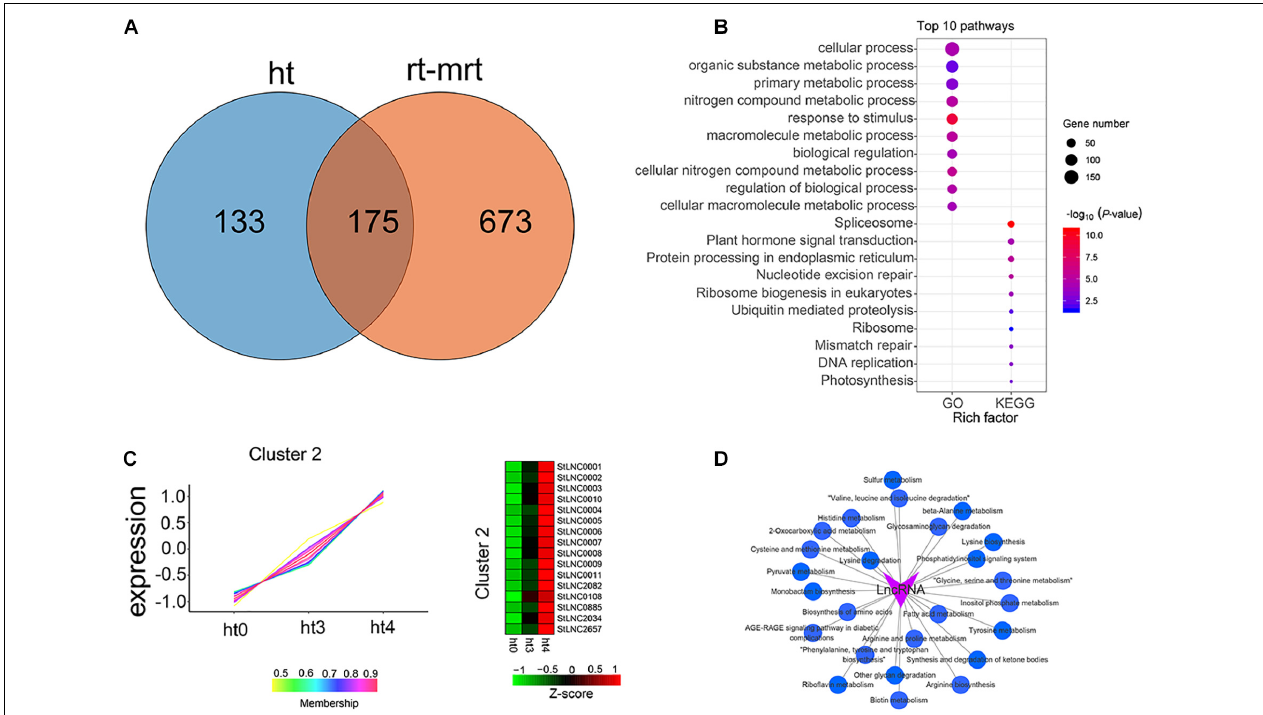
FIGURE 5 | Identification and characterization of specific lncRNAs from P. infestans –infected RB tissue. (A) Venn gram showing the distribution of DELs in ht ( P. infestans -infected RB tissues) and rt-mrt ( P. infestans -infected WT and mock-treated RB tissues and WT). (B) GO and KEGG enrichment analysis of targets of 133 specific DELs in RB tissue infected by P. infestans and the top 10 pathways are shown. The circle size represented the gene number. Blue to red represents the low to high P -value. (C) TCseq was performed to cluster 133 specific DELs, and heat maps show the expression patterns of lncRNAs from cluster 2. Green color represents the low expression level and red is the high expression level. (D) The interactive network between lncRNAs from cluster 2 and the significantly enriched pathways.